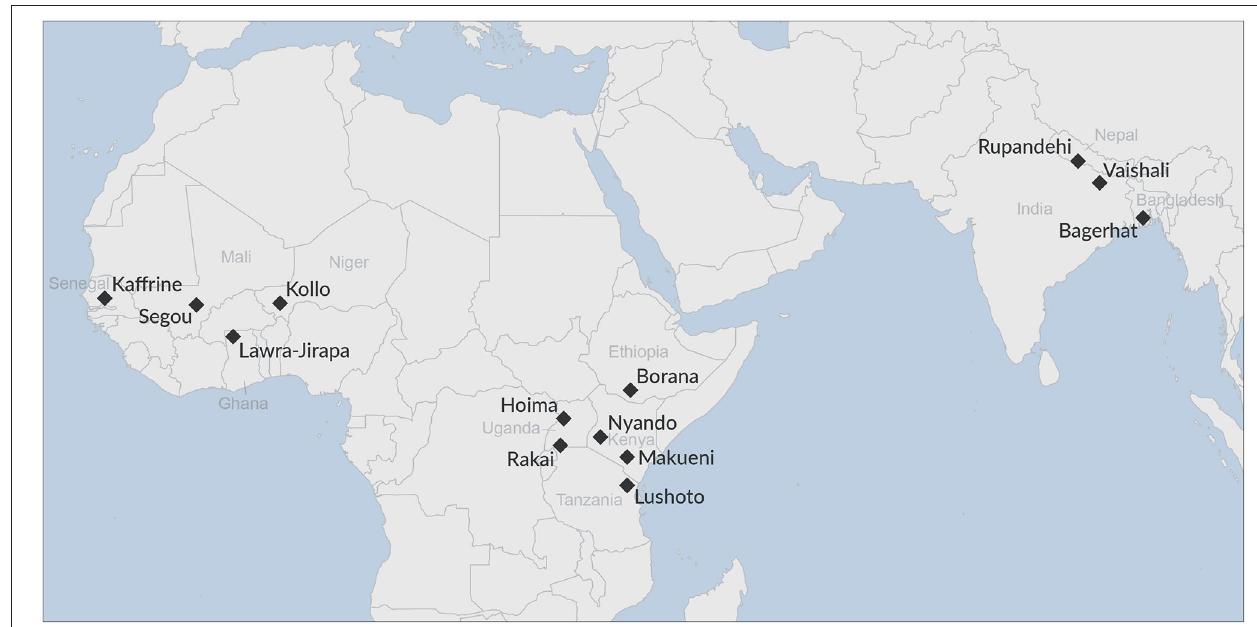
FIGURE 1 | Location of data